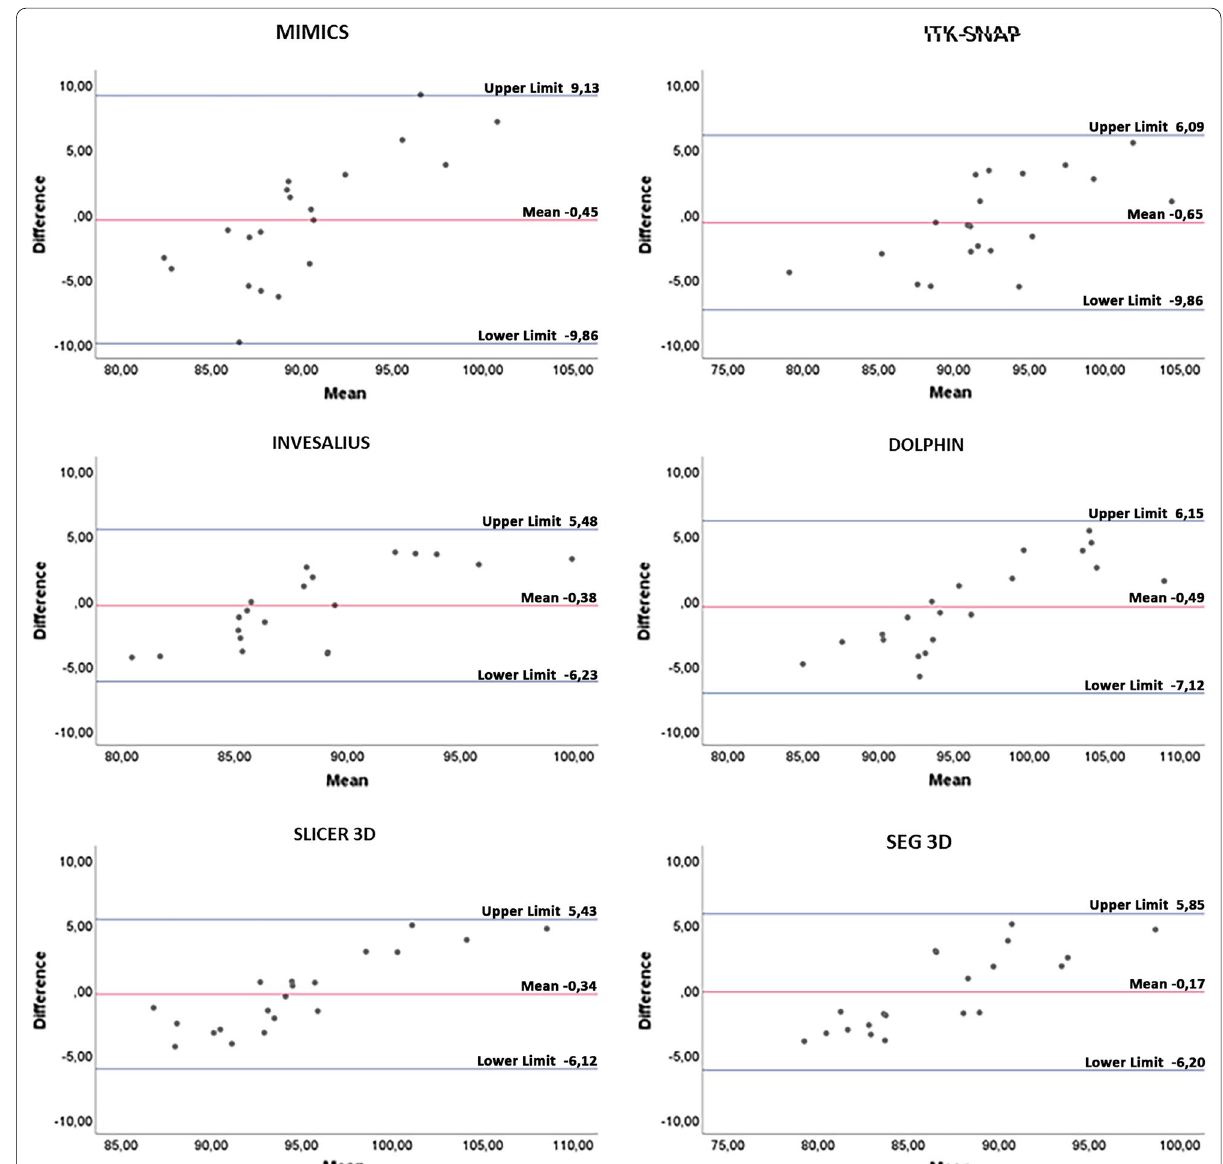
Fig. 8 Bland–Altman plot with lines of agreement between first and second inter-operator readings of semi-automatic segmentation of the upper